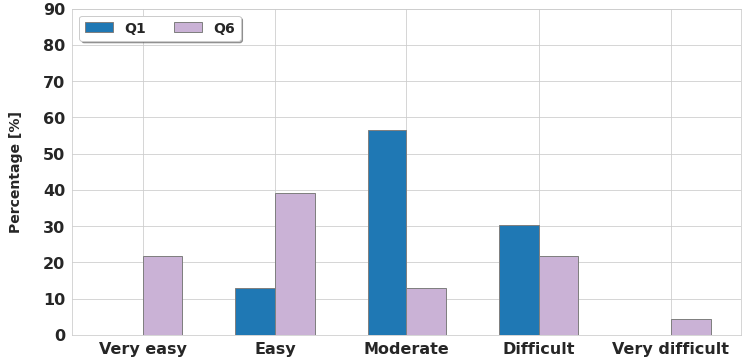
Figure 6. Survey responses to questions Q1 and Q6.